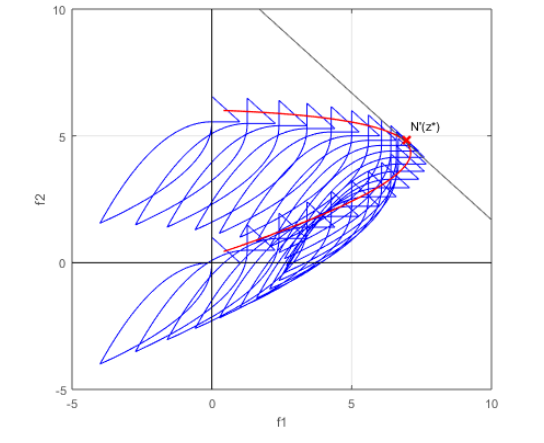
Figure 7. Collectively optimal Nash payoff N (cid:48) ( z ∗ µ )